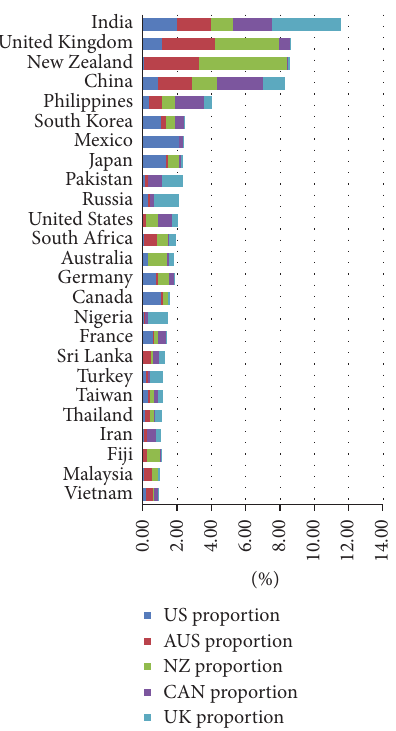
Figure 1: Combined averages of arrivals,